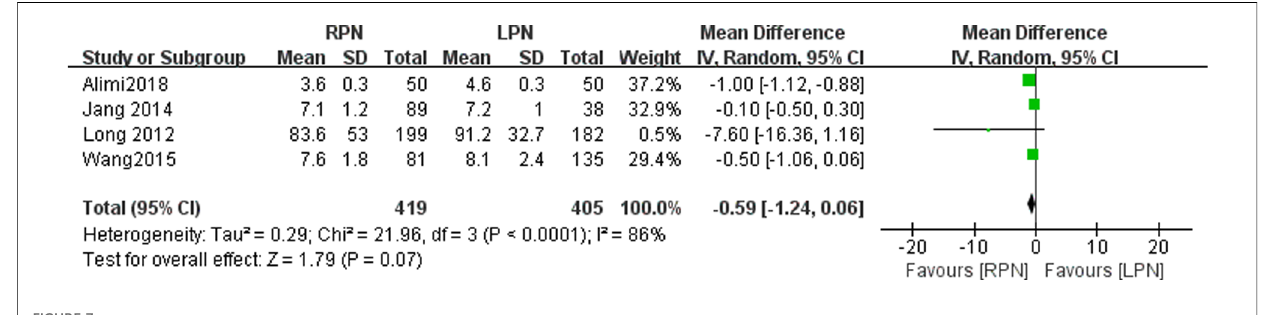
FIGURE 7 Forest plot for hospital stay between the RPN and